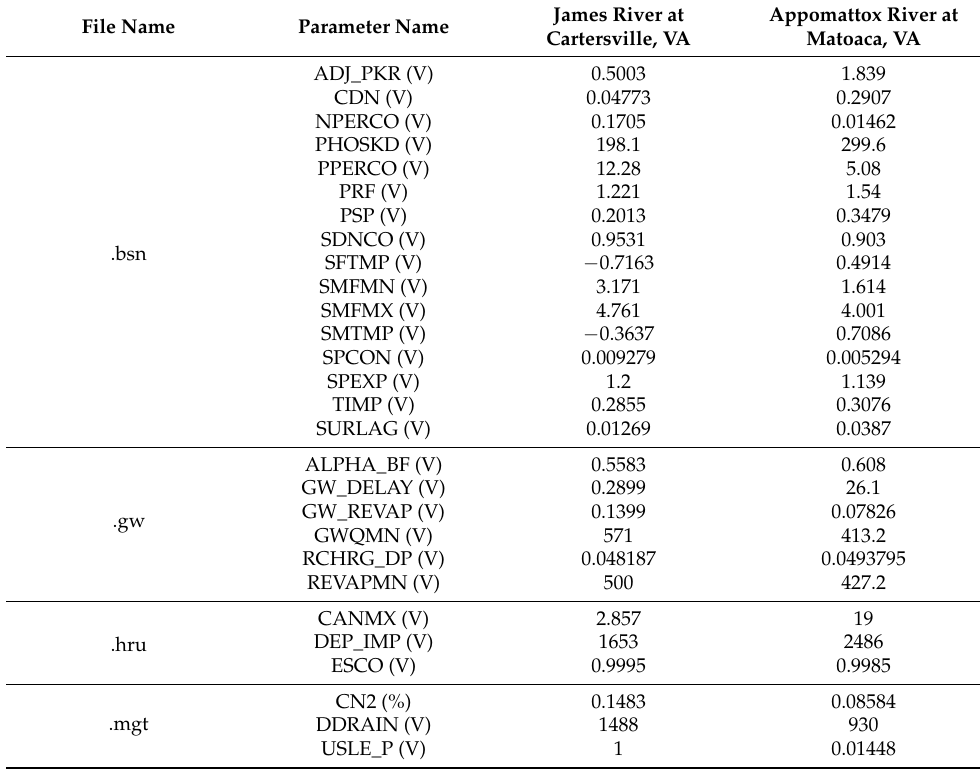
Table A1. SWAT parameters and calibration adjustment